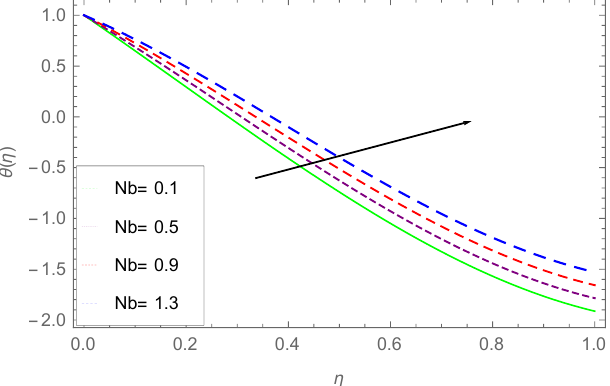
Figure 6. Impact of β on θ ( η ) , when S = 0.6, (cid:101) = 0.5, Nb = 0.5, Nt = 0.3, Sc = 0.1, Pr = 0.7.